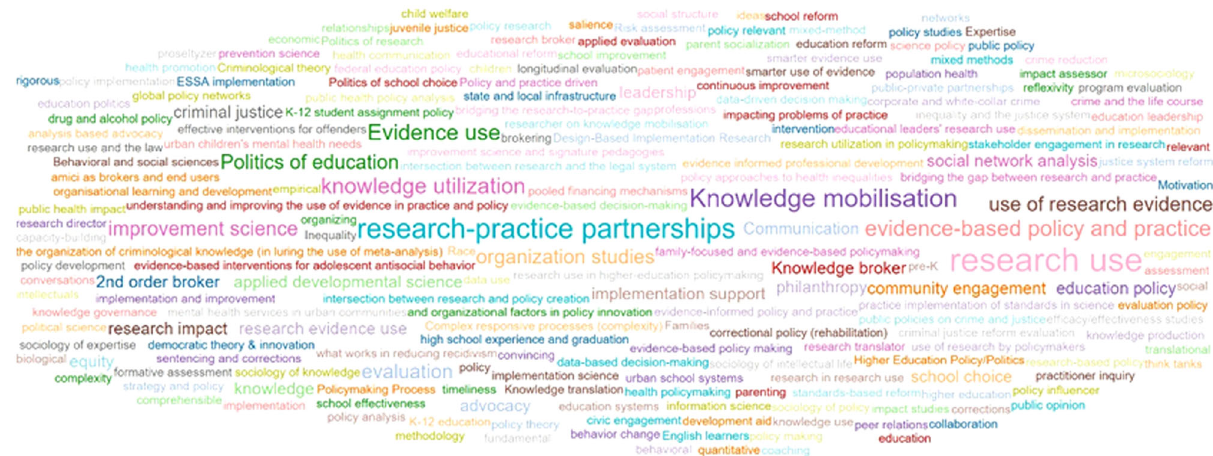
Fig. 4 Word cloud of key words. Key words listed by survey respondents are represented by frequency (larger text indicates greater frequency) using Tableau